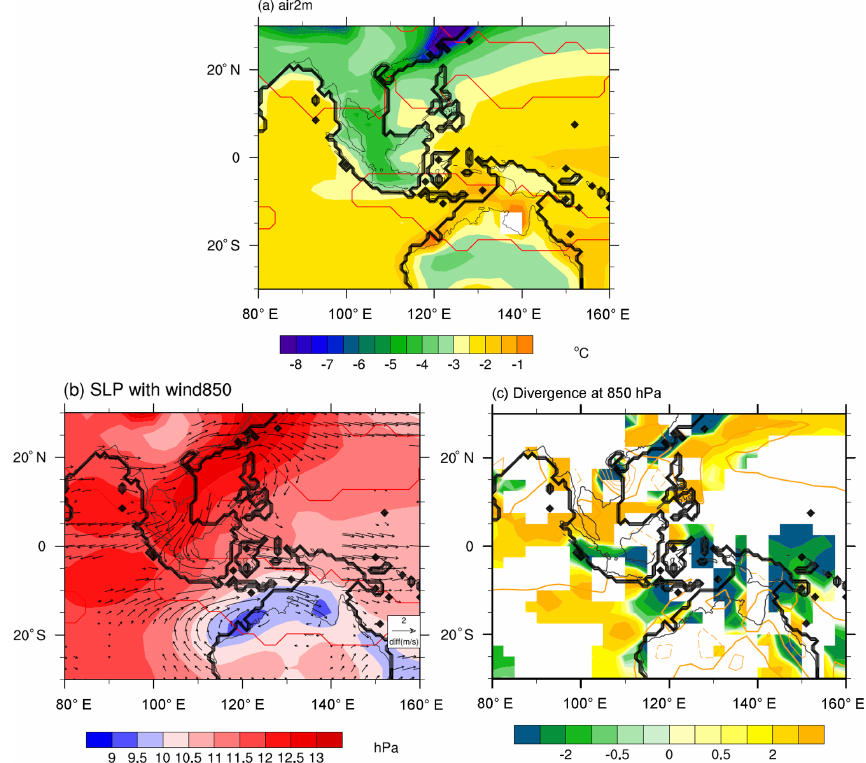
Figure 9. ND mean (a) surface air temperature, (b) sea level pressure (shading) with 850hPa wind (vector), and (c) 850hPa divergence difference between LGME and piControl (shading). The red lines in (a) and (b) enclose the monsoon domains. The orange lines in (c) represent the climatology derived from piControl. The thick black lines denote the coastal lines in LGME provided by CMIP5–PMIP3, and the thin black lines denote the coastal lines in piControl. Only those areas where the signal-to-noise ratio exceeds 1 are plotted.